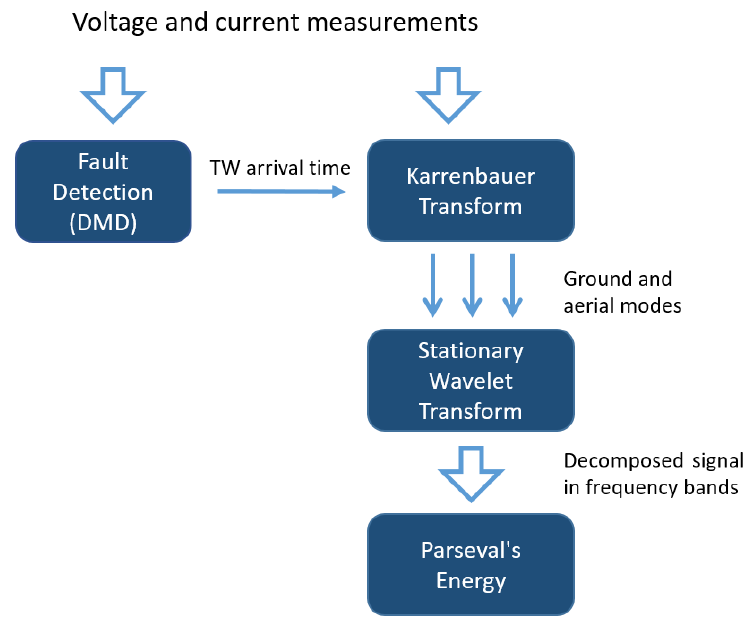
Figure 1. Workflow of the signal processing